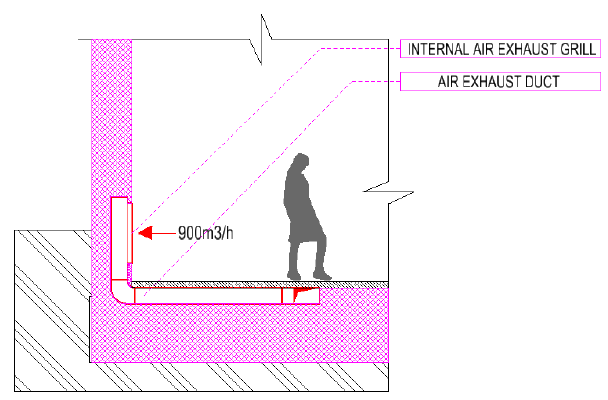
Figure 5. Cross-section of the investigated room with specified quantities of supplied air.